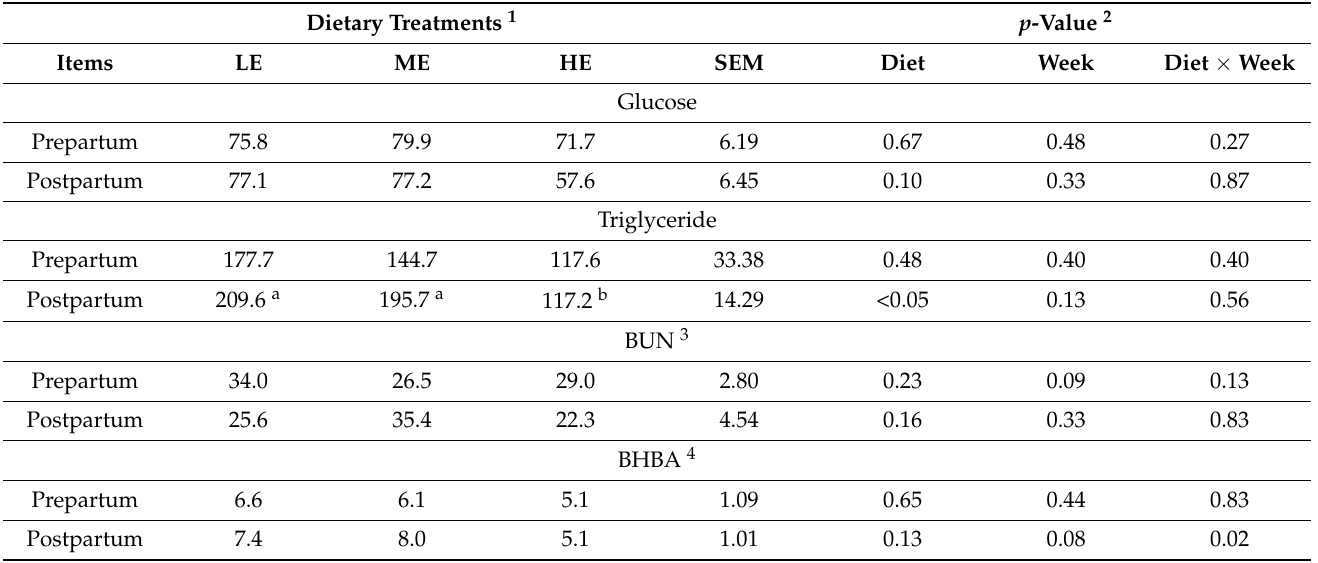
Table 4. Serum metabolites (mg/dL) of Nili Ravi buffaloes fed different levels of